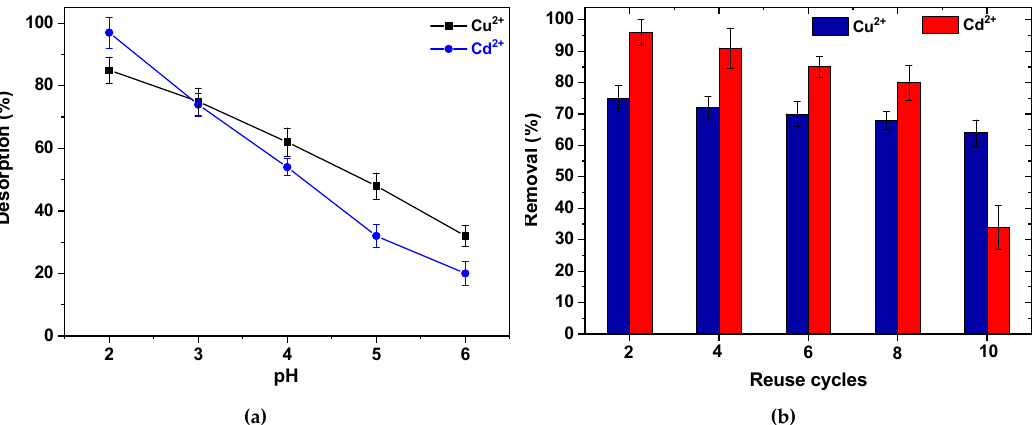
Figure 12. ( a ) Effect of pH on desorption of Cu 2+ and Cd 2+ from CS-HMF3 derivative. ( b ) Reuse cycles of CS-HMF3. Experimental conditions (adsorption): C 0 = 100 mg/L, V = 20 mL, N = 160 rpm, T = 25 °C, t = 200 min, pH = 5, m = 0.02 g; Experimental conditions (desorption): V = 20 mL, N = 160 rpm, T = 25 °C, t = 24 h, pH = 2, m = 0.02 g. The figures present the experimental points with errors bars calculated after standard deviation (n = 4).